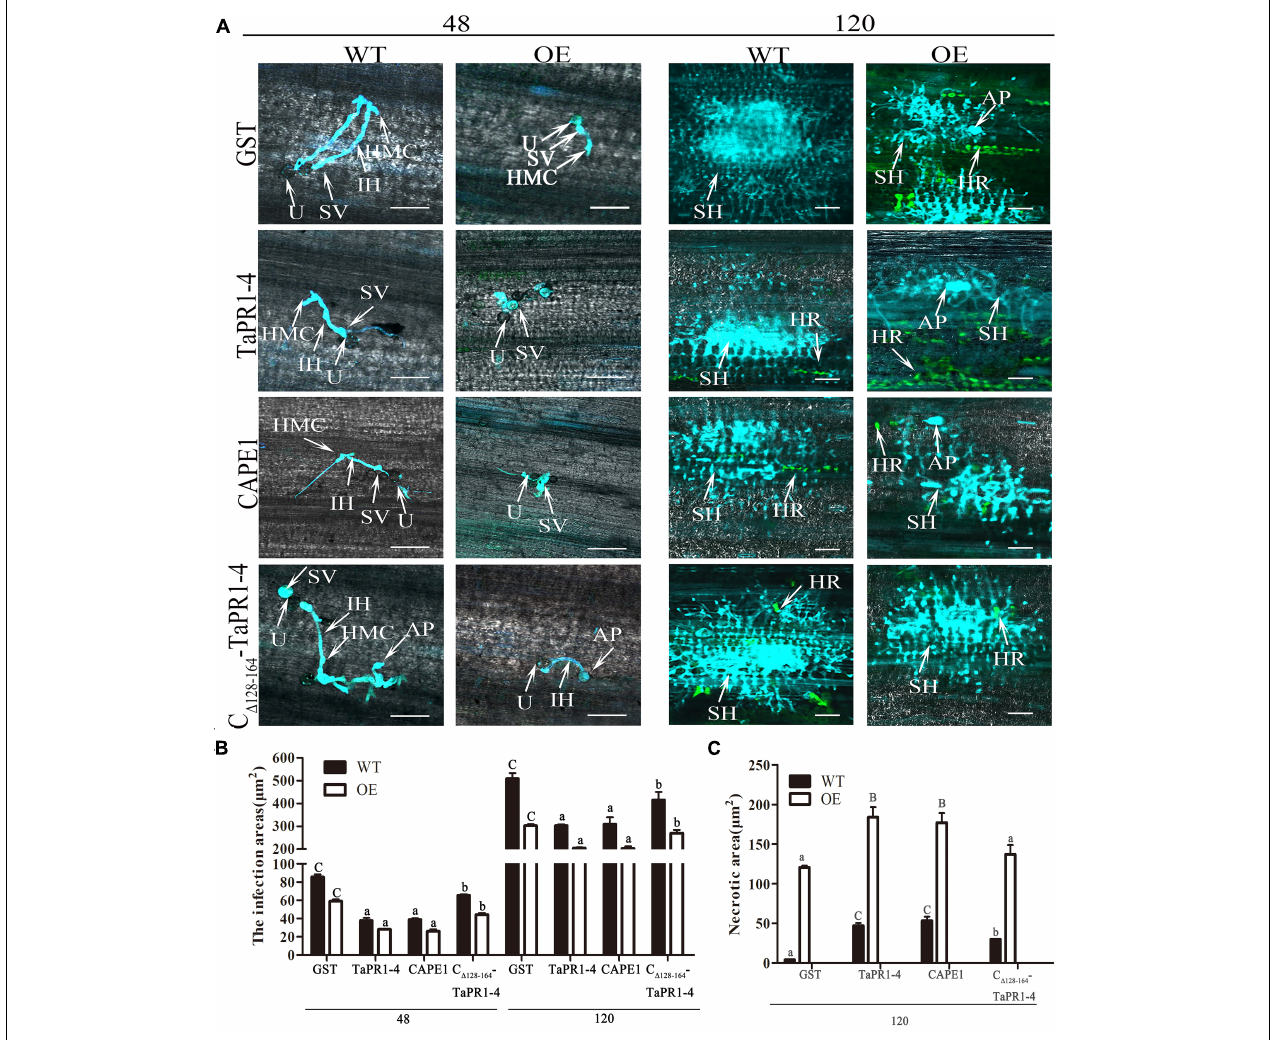
FIGURE 6 | Histological changes in both WT and TaTLP1-OE lines infected with Pt were observed. (A) Histology of hyphal development and host cell death during Pt infection at 48 and 120 hpi. GST, TaPR1-4, CAPE1 and C (cid:49) 128 − 164 -TaPR1-4 (0.1 mg/ml) were infiltrated into first and second leaves of TaTLP1-OE and WT lines (WT, JW1). U, urediospore; AP, appressorium; IH, infection hypha; HMC, haustorial mother cell; SH, secondary hypha; SV, substomatal vesicle; HR, hypersensitive reaction (green color). Scale bars, 100 µ m. (B) The area of infection was measured using ImageJ software. Values are means ± SEM of three independent biological replicates. Significant differences were assessed using one-way analysis of variance (ANOVA) and Duncan’s multiple range test (DMRT) with p < 0.05. (C) The necrotic area was measured using ImageJ software. A minimum of 50 infection sites were examined. Values are means ± SEM of three independent biological replicates. Significant differences were assessed using one-way analysis of variance (ANOVA) and Duncan’s multiple range test (DMRT) with p <